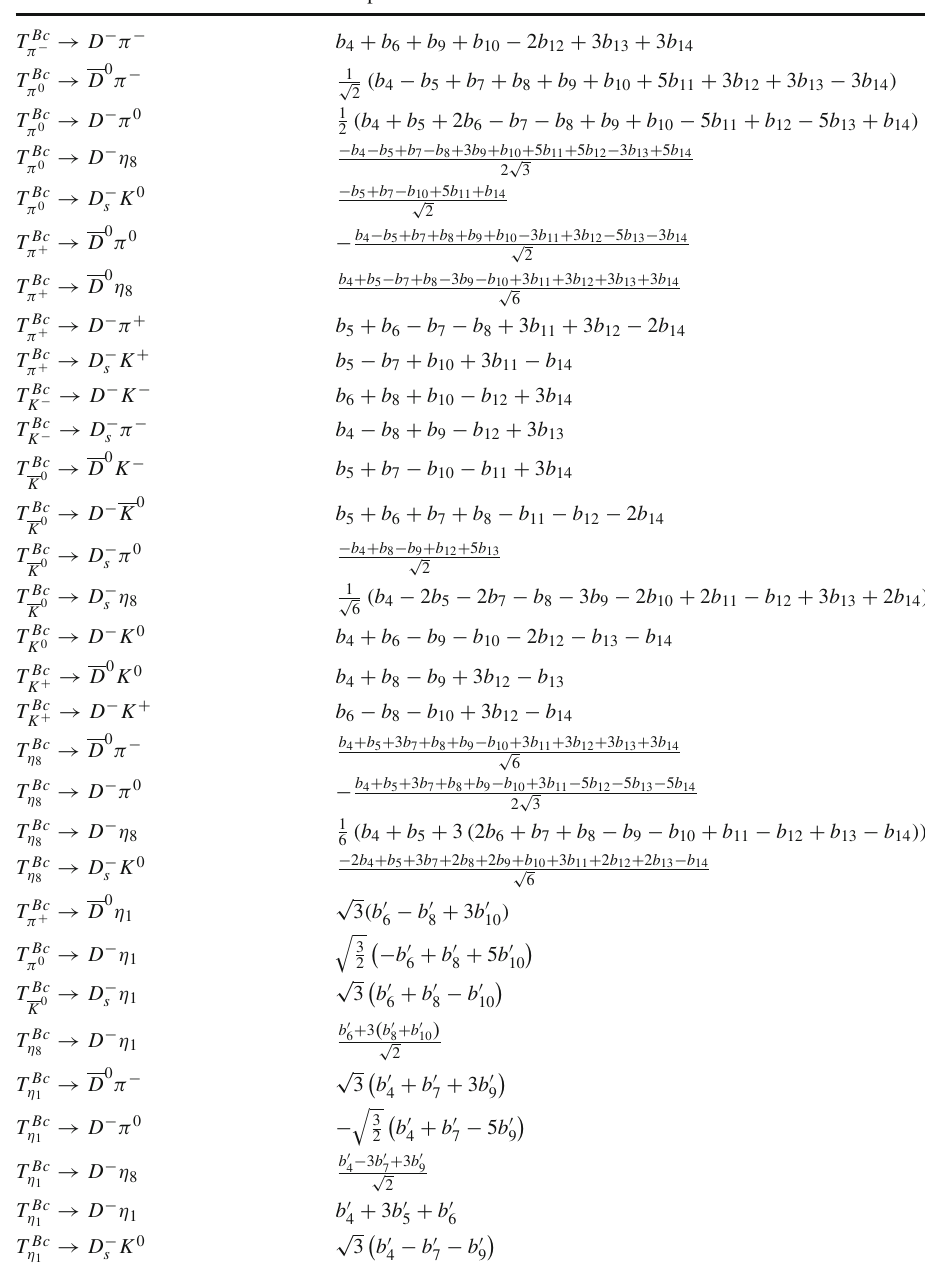
Table 6 Tetraquark T b ¯ c 8 / T b ¯ c 1 decays into anti-charmed and light mesons induced by the charmless b → d